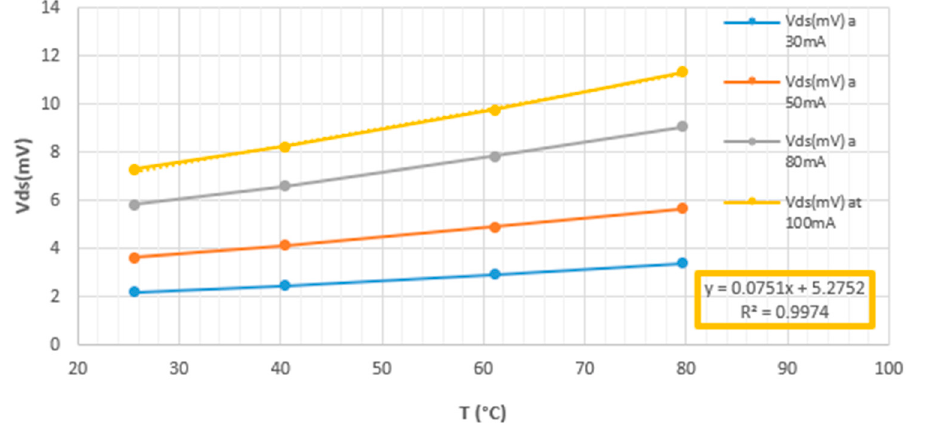
Figure 5. Calibration curves of V ds.